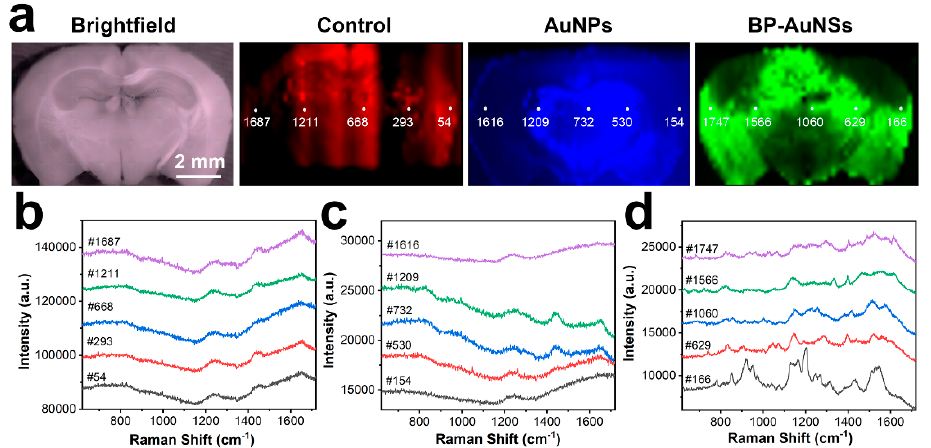
Figure 3. ( a ) Full-scale label-free SERS imaging of mouse brain section. ( b – d ) Raw Raman spectral lines collected from five pixel points in the brain sections treated without ( b ) or with nanostructures (AuNPs ( c ) and BP-AuNSs ( d )).